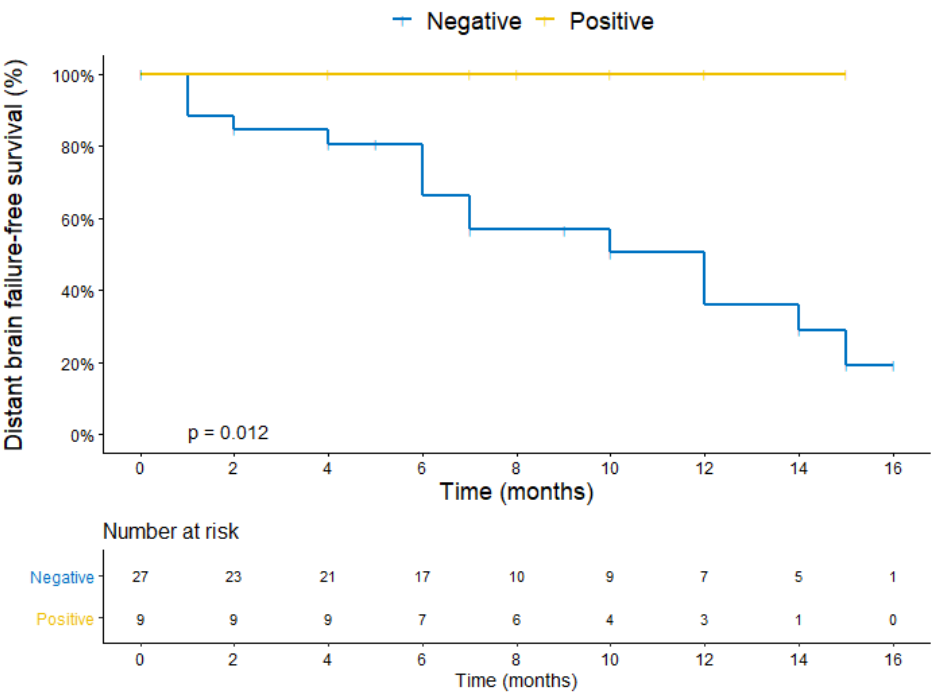
Figure 4. Kaplan – Meier plot for distant brain failure-free survival stratified by HER2 expression in the CTC1 or CTC2.